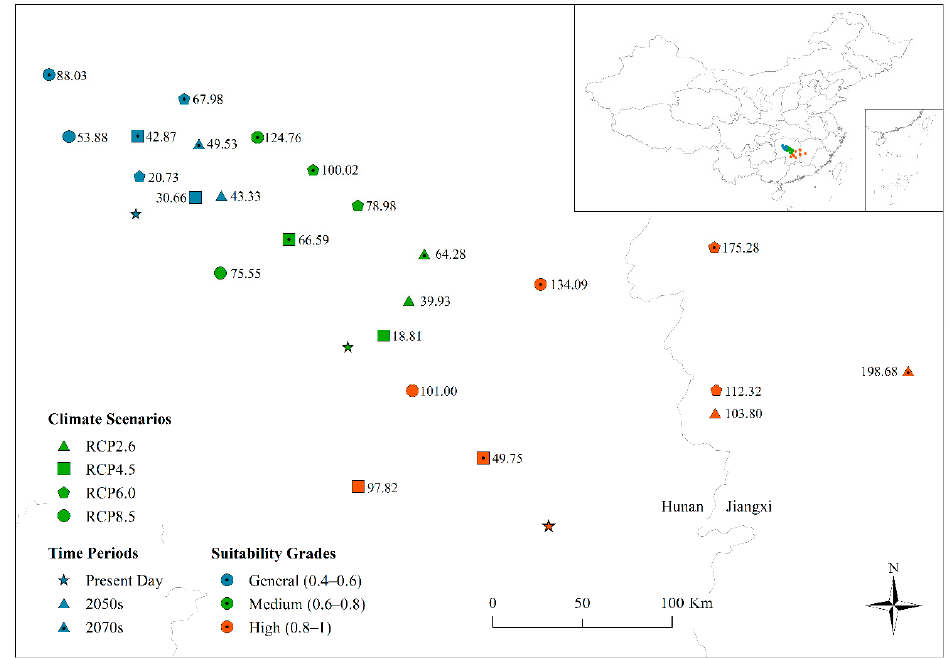
Figure 6. Centroid distributions of general-, medium-, and high-suitability areas for Cunninghamia lanceolata for the present day, 2050s, and 2070s under different climate change scenarios. Point numbers represent the distance (km) between the predicted and present-day centroids. Cimate scenarios are distinguished by a given symbol; for time periods, present day is displayed by a star, and 2050s and 2070s are distinguished by the center of symbols; suitability grades are distinguished by the color.